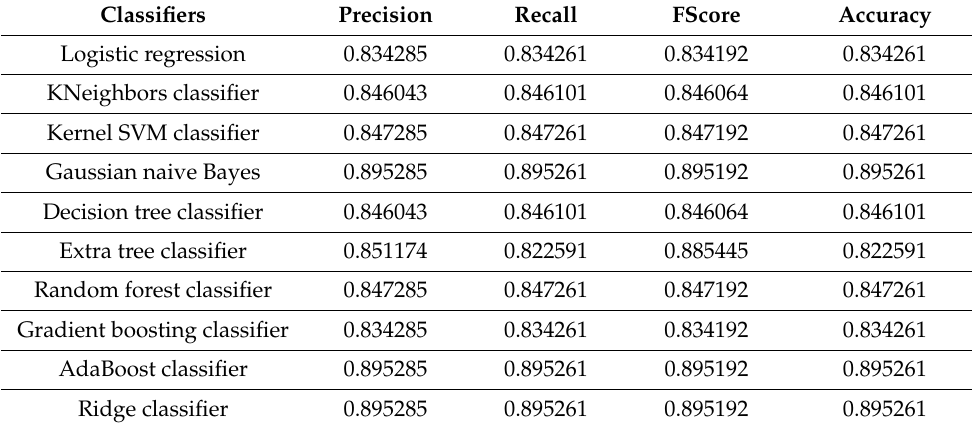
Table 11. Gradient boosting regressor metrics before feature